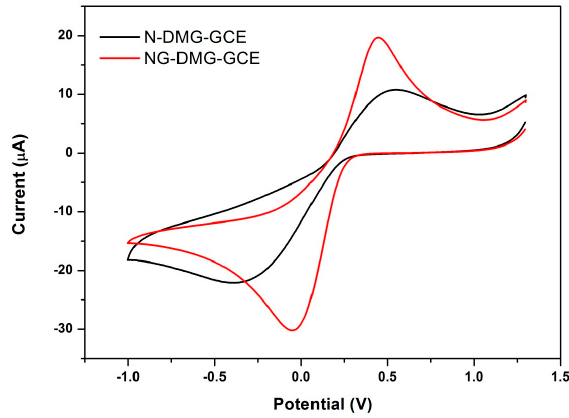
Figure 8. Cyclic voltammograms of 5 mM Fe(CN) 63 − /4 − at N-DMG-GCE (black) and NGr-DMG-GCE (red) in supporting electrolyte of 1 M KCl at scan rate 50 mV s − 1 .